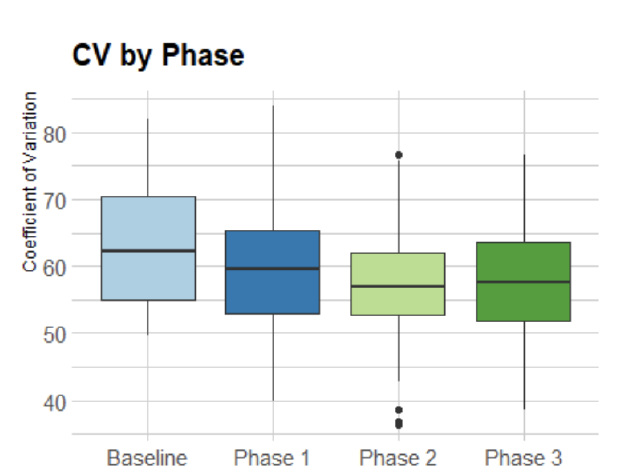
Figure 3. The coefficient of variation* among the baseline, Phase 1, Phase 2, and Phase 3 portions of the project. *Lower coefficient of variation in all phases compared to base - line showed improved level loading of the system with improved patient transport distribution. CV, coefficient of